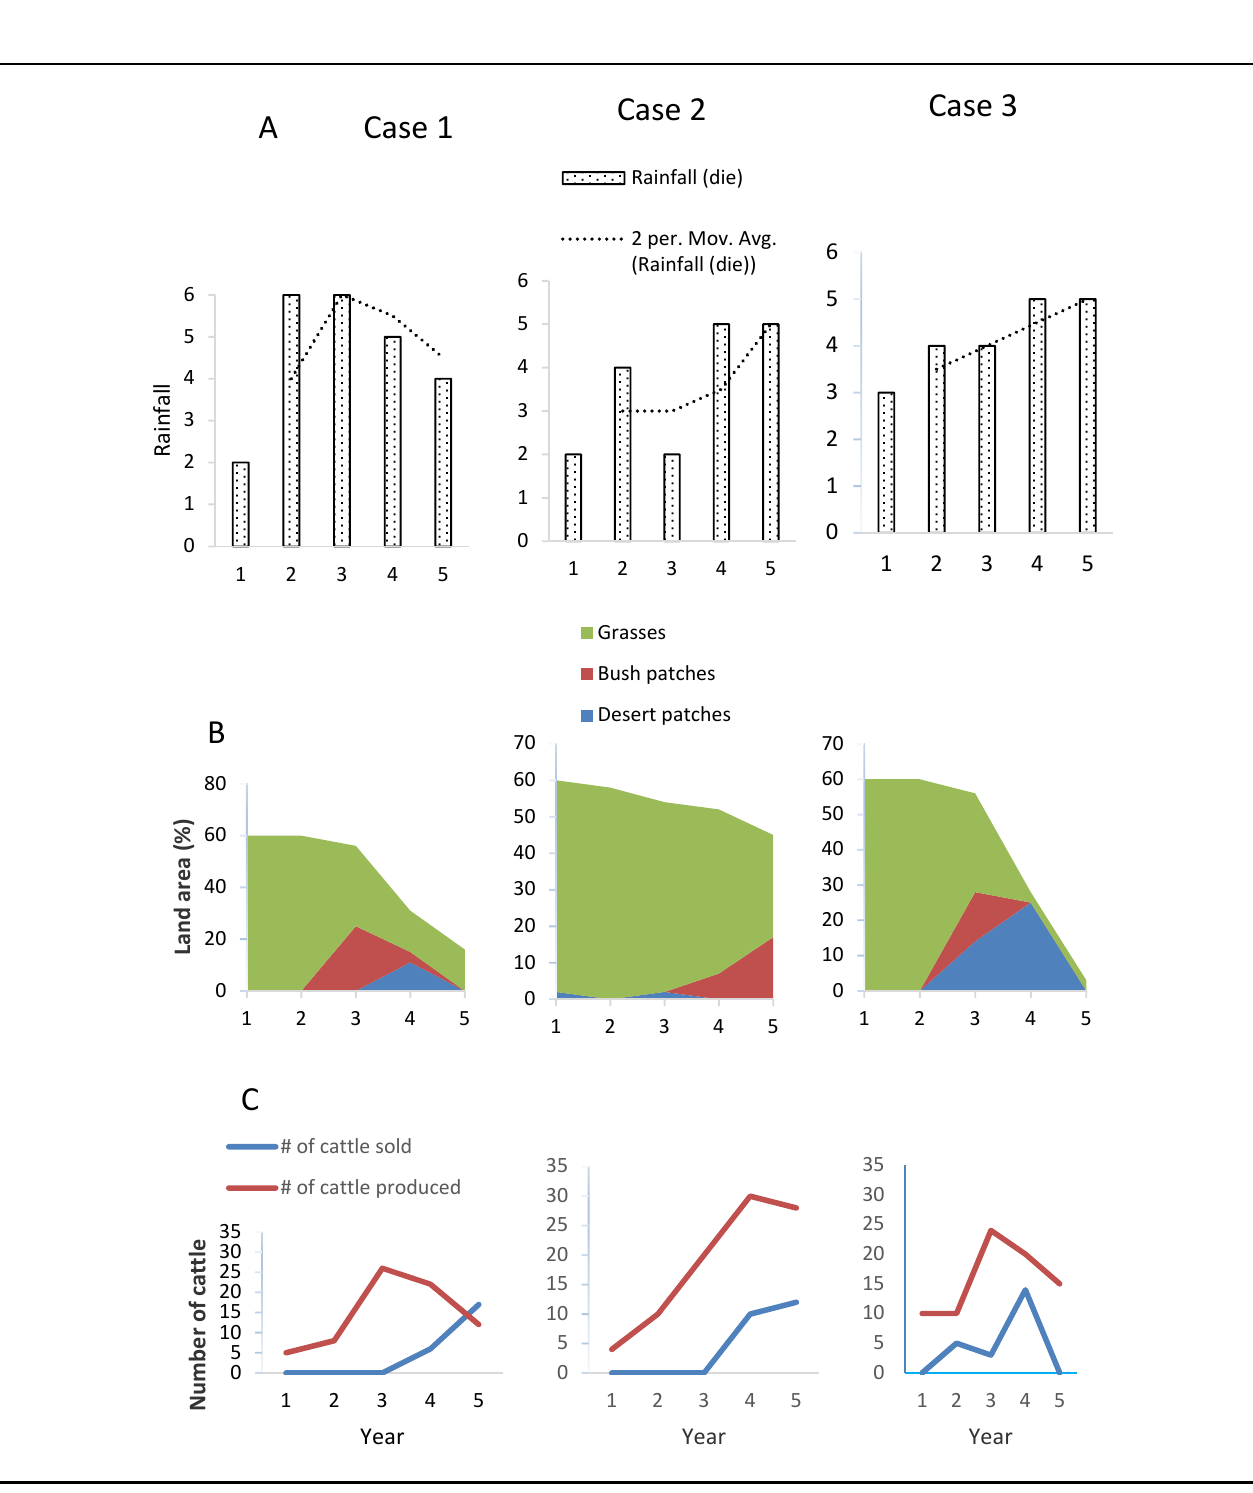
Figure 11. Results of male grazing game depicting rainfall patterns under dry conditions with decreasing rainfall (Case 1), dry conditions with ascending rainfall (Case 2) and wet conditions with ascending rainfall (Case 3): ( A ) pattern of average rainfall, ( B ) land use patterns, and ( C ) cattle production trends (n female games = 22; n male games = 22).